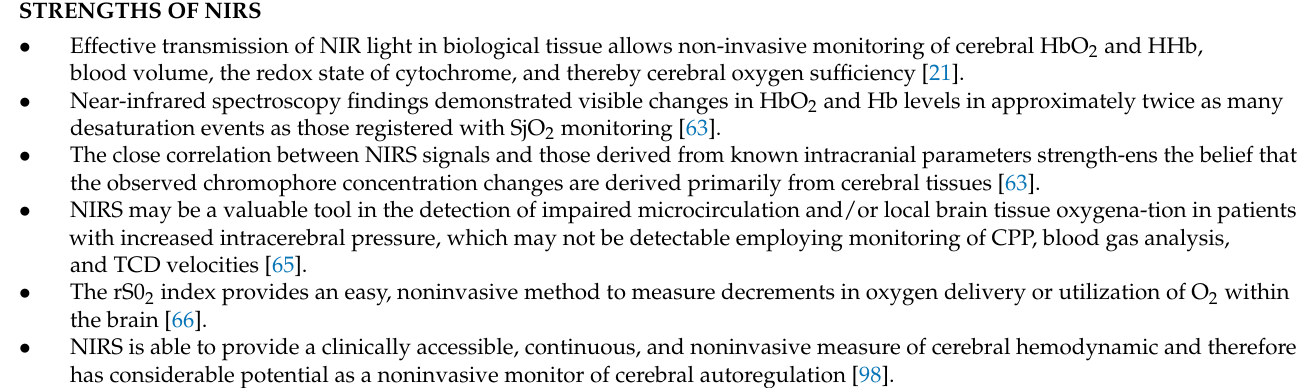
Table 3. Strengths and limitations of NIRS-derived oxygenation in